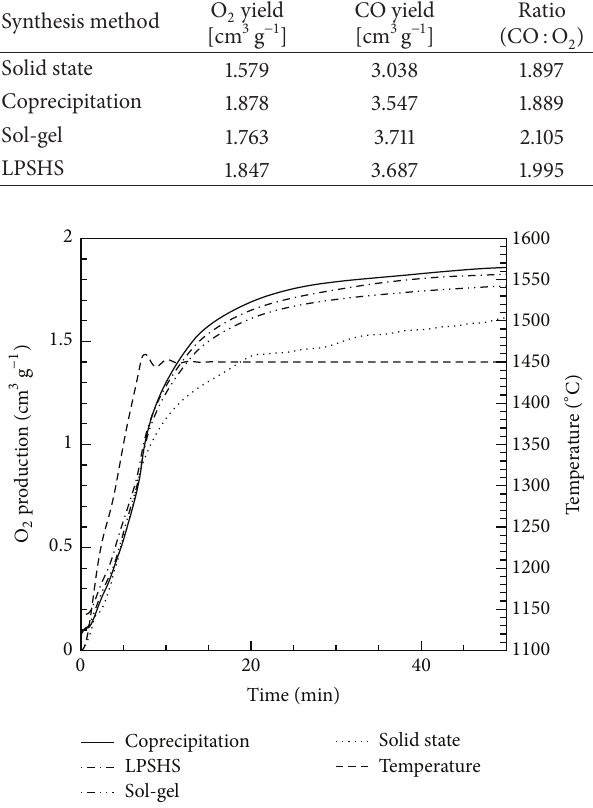
Figure 6: O 2 production versus time during the reduction step of the 5th